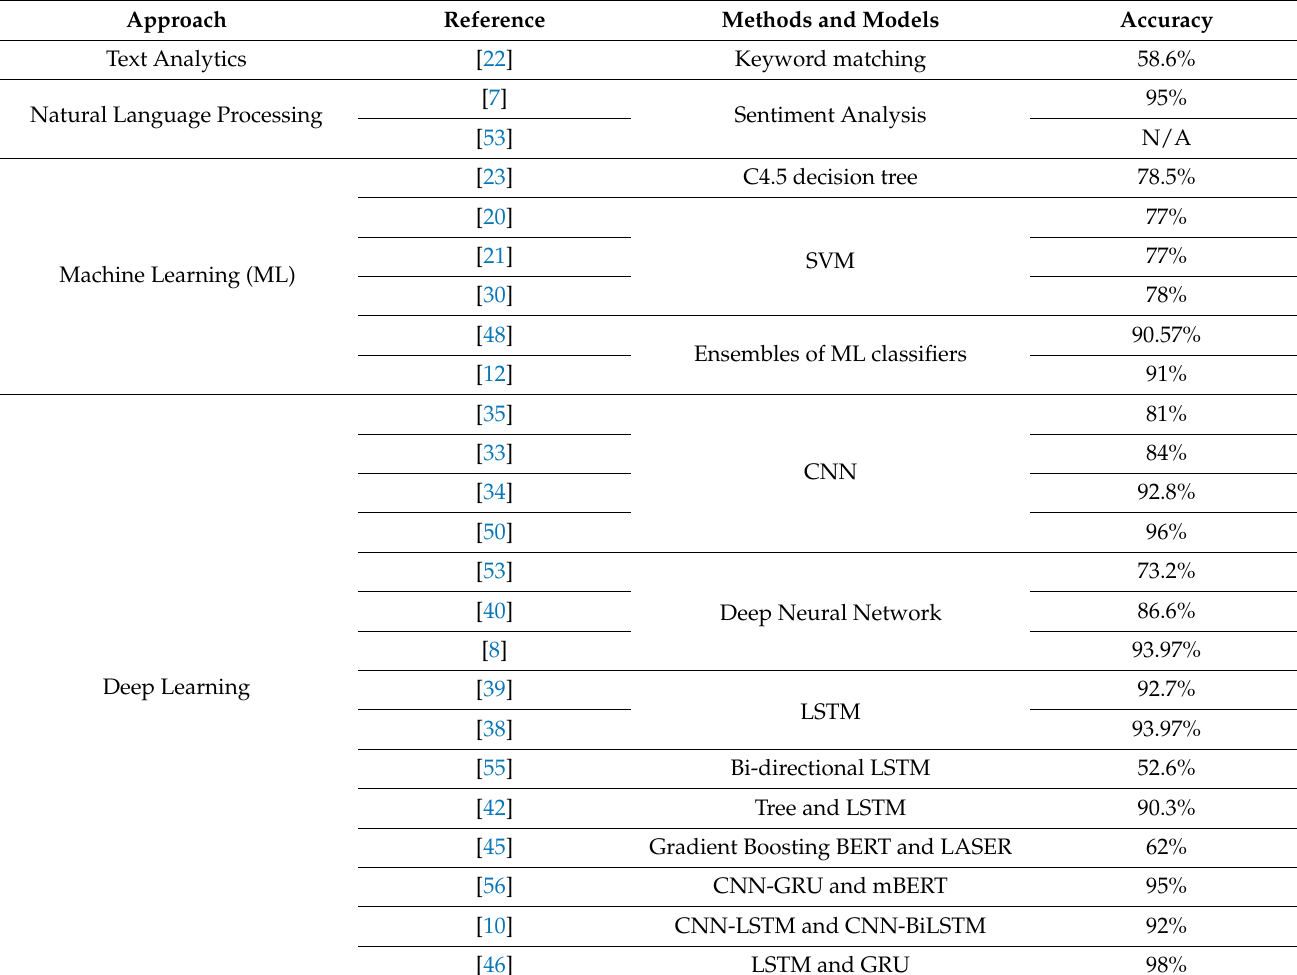
Table 1. State-of-the-art research on cyber bullying